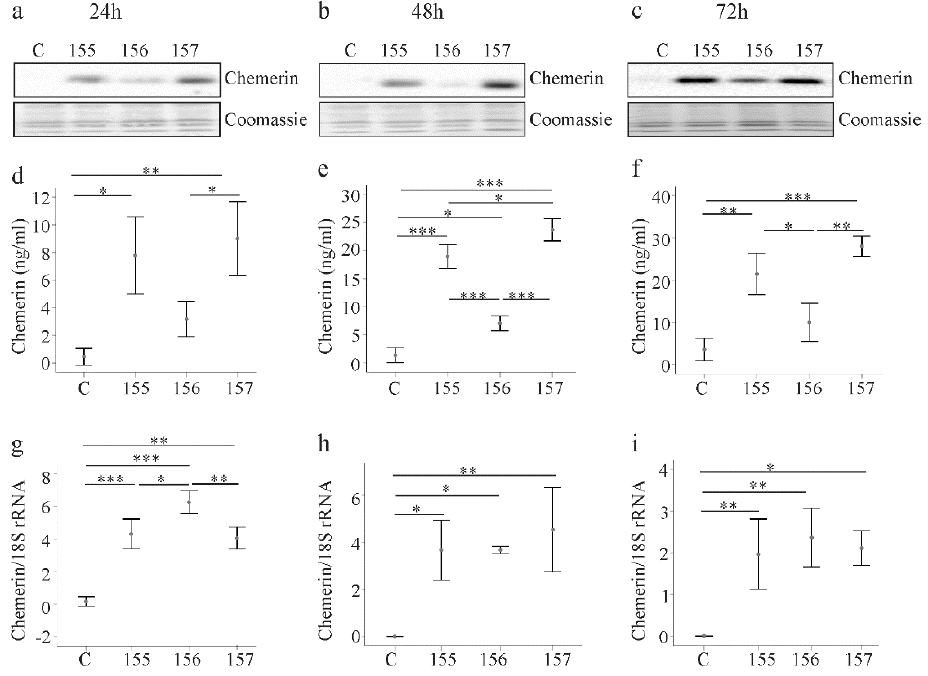
Figure 1. Expression of chemerin isoforms in LX-2 cells. ( a – c ) LX-2 cells were transfected with an